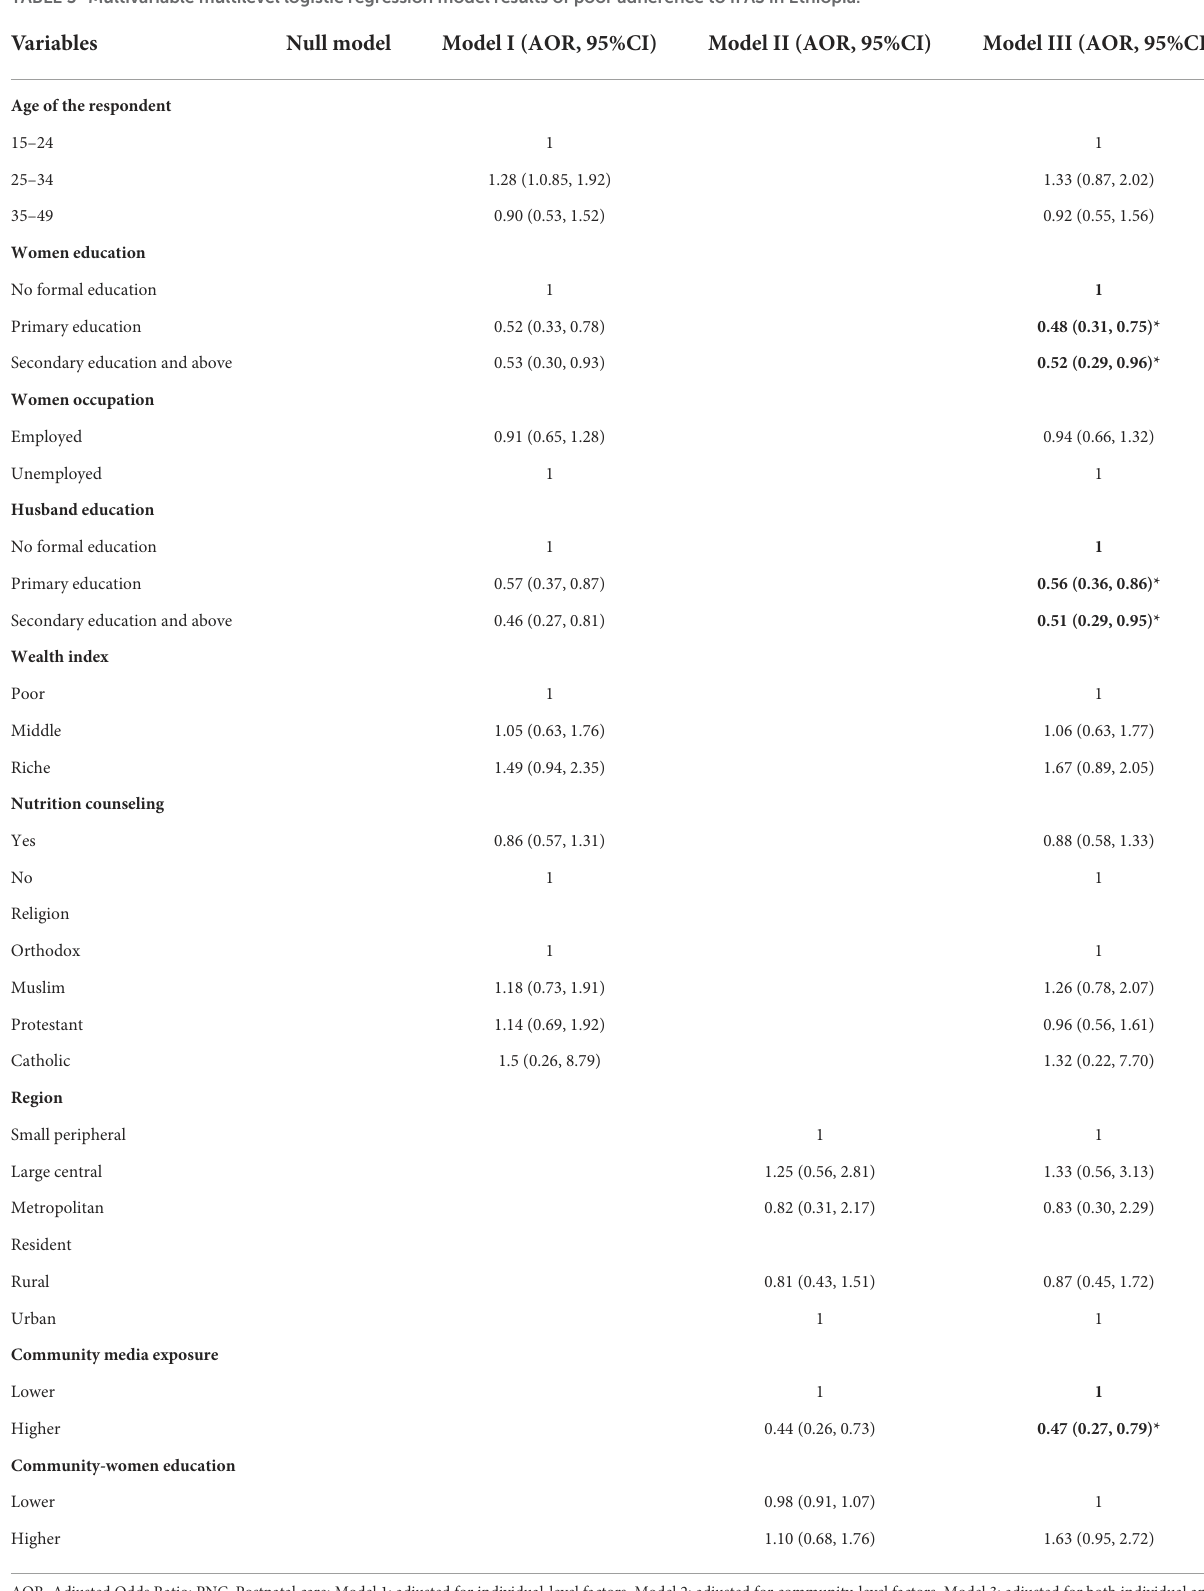
TABLE 3 Multivariable multilevel logistic regression model results of poor adherence to IFAS in